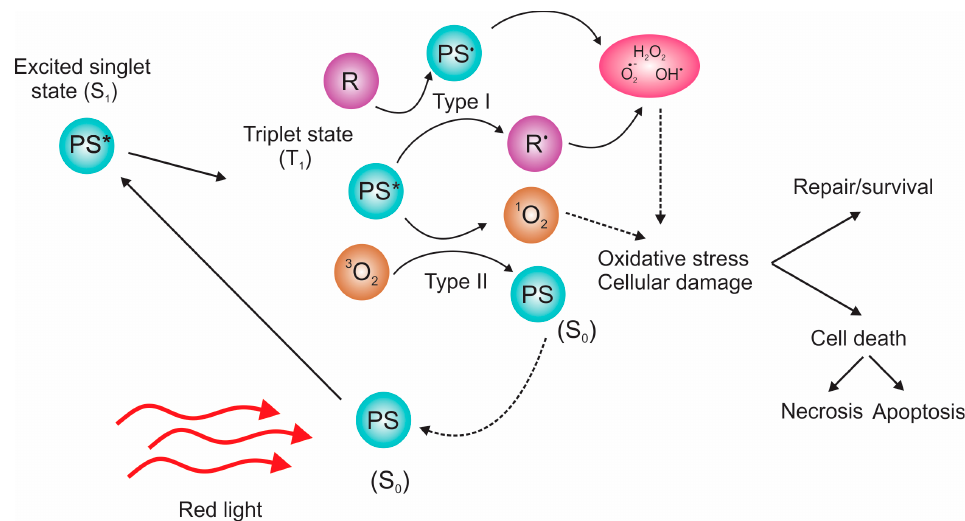
Figure 1. The mechanism of PDT: when PSs are irradiated by light, they transfer from singlet ground state (S 0 ) to excited singlet state (S 1 ), followed by intersystem crossing to excited triplet state (T 1 ). ROS are generated by transferring energy from T 1 via Type I and Type II reactions.